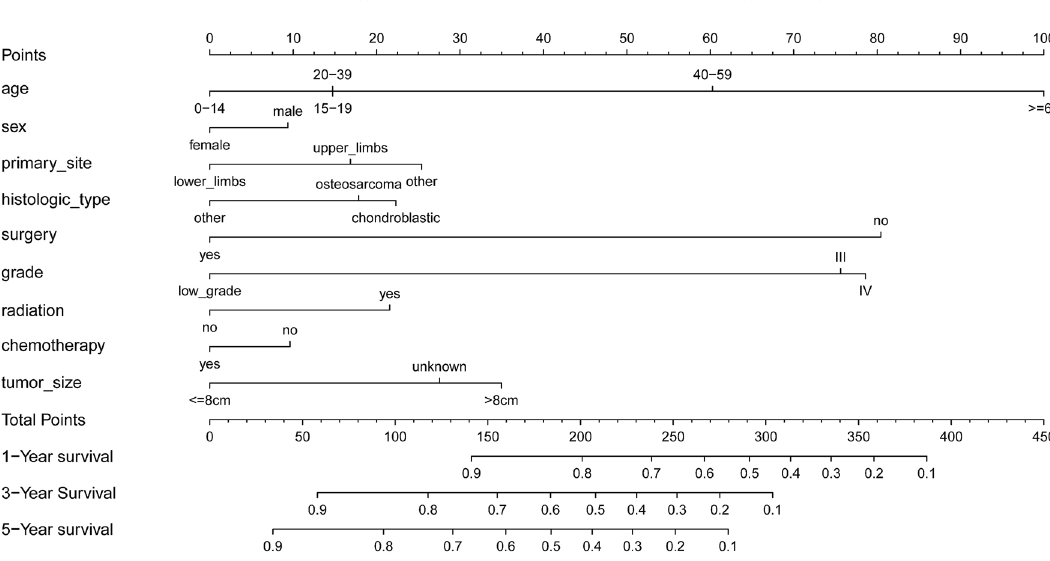
Figure 6. Nomogram predicting 1-, 3-,